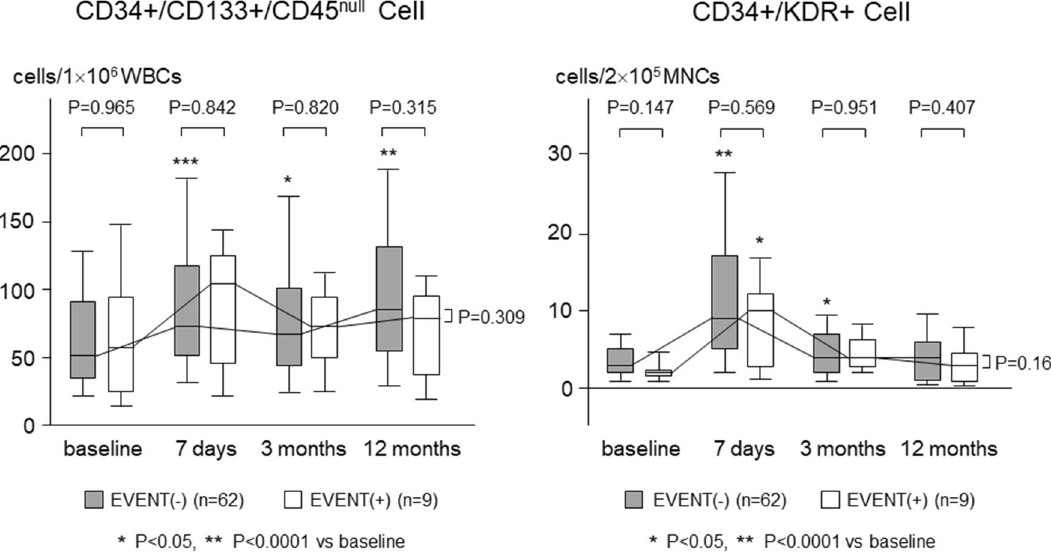
Figure 7. Comparison of serial changes in circulating progenitor cells between patients who experienced the event such as revascularization other than target lesion at 12 months follow-up and those who did